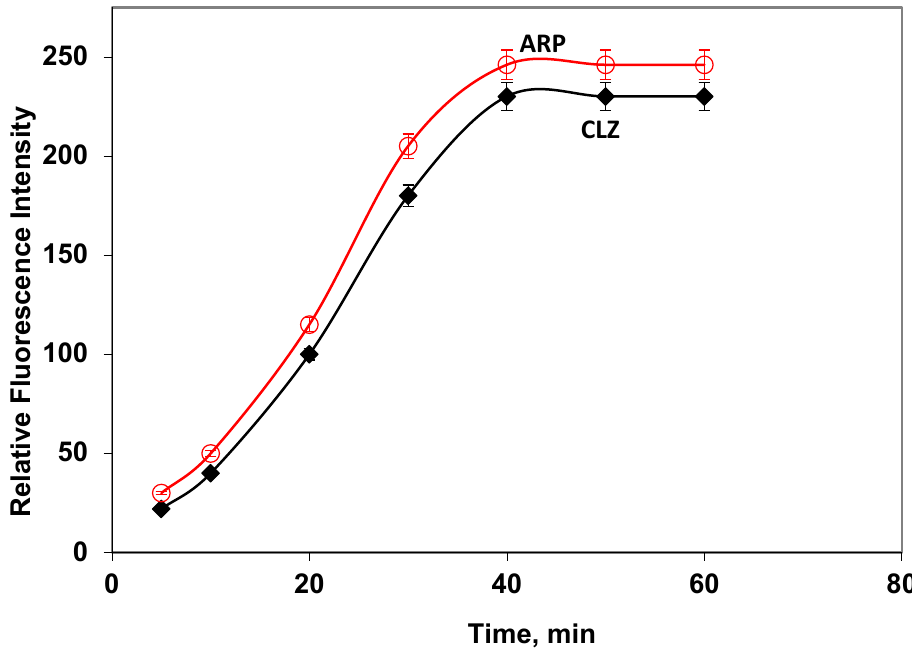
Figure 5. Effect of reaction time on the relative fluorescence intensity of the reaction product of ARP and CLZ with o -phthalaldehyde.